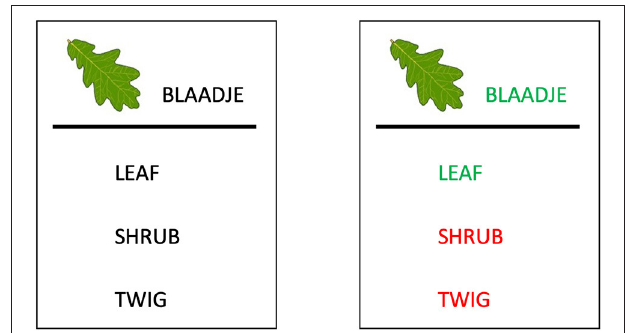
FIGURE 3 | (Left) Example of a trial. At the top, the word in the native language (Dutch), at the bottom three possible English translations. In this example, the words are semantically similar, and in the contrasted condition. (Right) Example of the feedback after children have clicked on an answer. The correct translation pair becomes green, the incorrect answers are